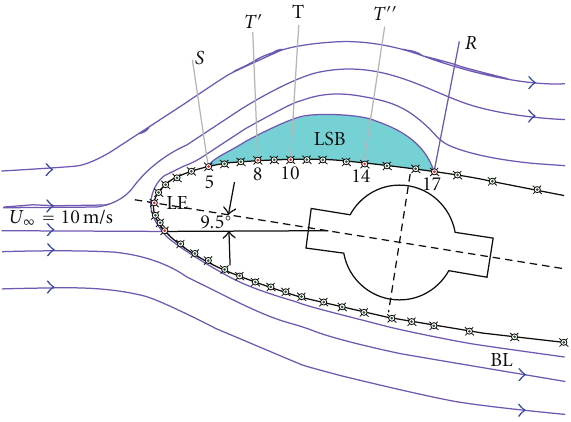
Figure 9: Schematic diagram of mean flow with LSB.